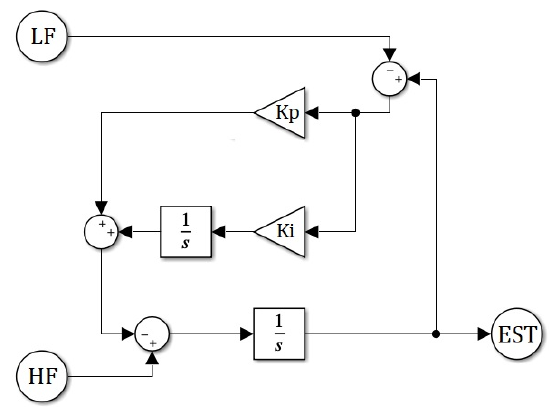
Figure 4. Non-linear complementary filter diagram. The non-linear CF (NCF) is based on the proportional–integral controller, in which the proportional part manages the low-frequency input and the integral part handles the high-frequency signal. (cid:1837) (cid:3043) and (cid:1837) (cid:3036) indicate the proportional and integral gain, respectively [ 27 ]. The non-linear complementary filter transfer function is represented by Equation (14). The amplitude and phase shift of the NCF is presented in Figure 5. Figure 5. Bode diagram (amplitude and phase) for non-linear CF. (cid:1831)(cid:1845)(cid:1846) = (cid:1837)(cid:1868) ∙ (cid:1871) + (cid:1837)(cid:1861) (cid:1871) (cid:2870) + (cid:1837)(cid:1868) ∙ (cid:1871) + (cid:1837)(cid:1861) ∙ (cid:1838)(cid:1832) + (cid:1871) (cid:2870) (cid:1871) (cid:2870) + (cid:1837)(cid:1868) ∙ (cid:1871) + (cid:1837)(cid:1861) ∙ (cid:1834)(cid:1832)